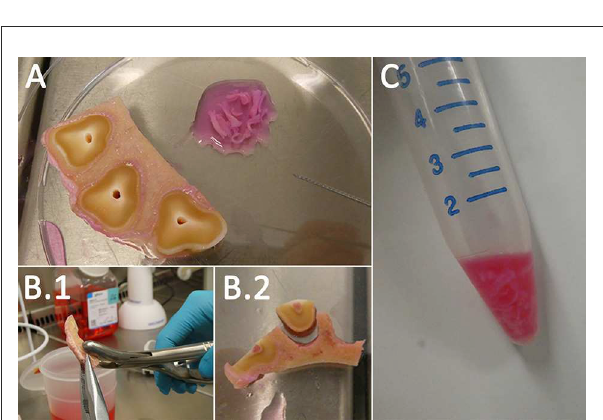
FIGURE3 Cell isolation. The dental pulp was pulled out of its cavity via Hedstrom files (A) . To obtain the PDL the tooth and the alveolar bone were separated (B.1, B.2) . Afterwards, the PDL was scraped from the surfaces. Both samples were digested in 2 mg/ml Collagenase I (C)